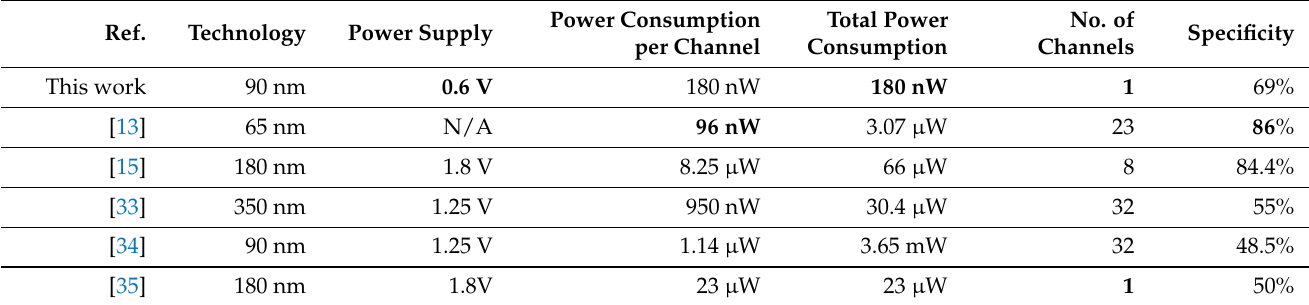
Table 5. Performance summary for analog epileptic seizure prediction